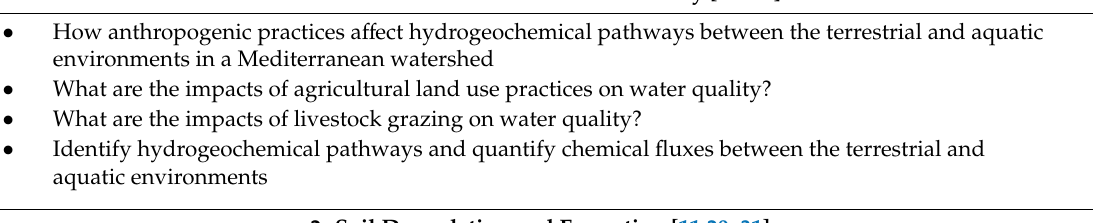
Table 1. Research Areas and Key Scientific Questions Addressed at the Koiliaris CZO and research citations related to